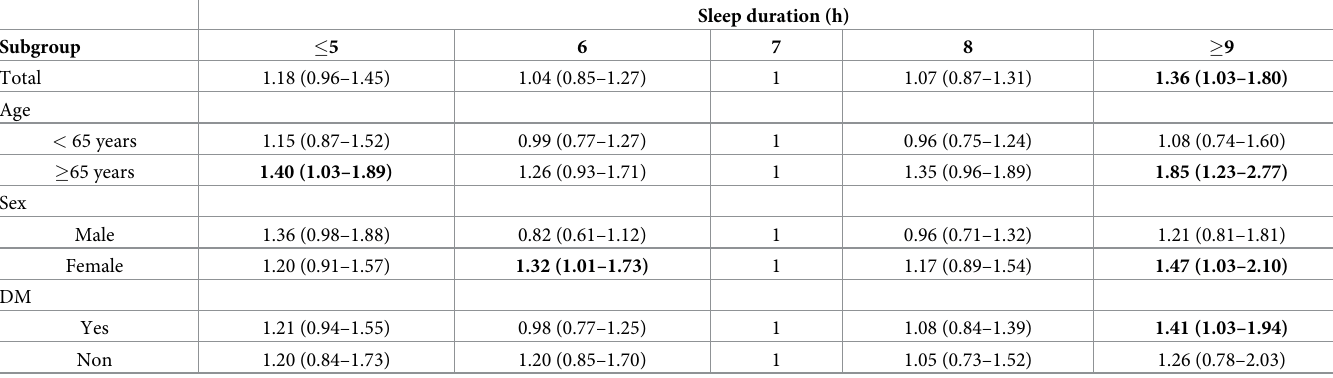
Table 3. Odds ratios (95% Cis) for albuminuria according to sleep